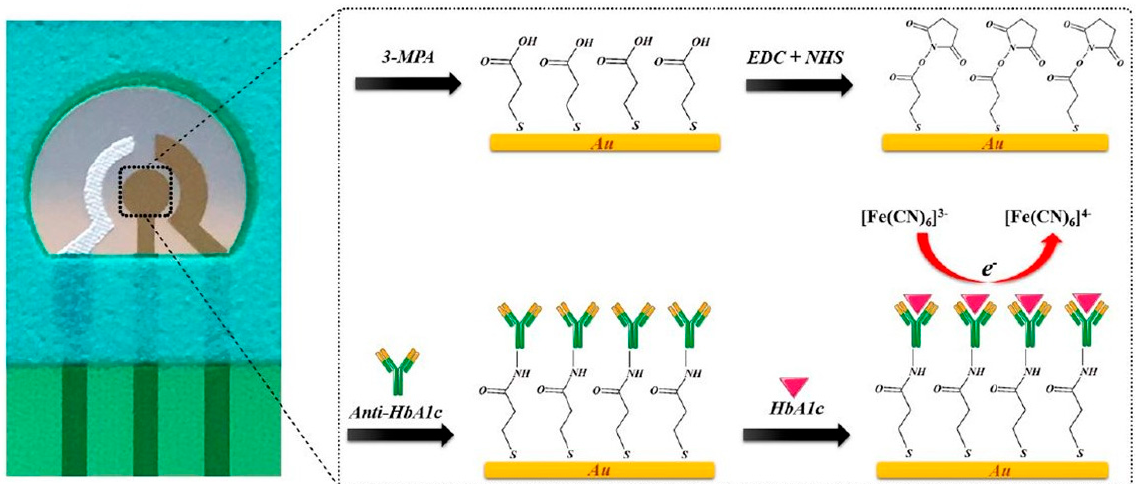
Figure 4. Electrochemical immunosensor based on gold as an interface for direct detection of HbA1c